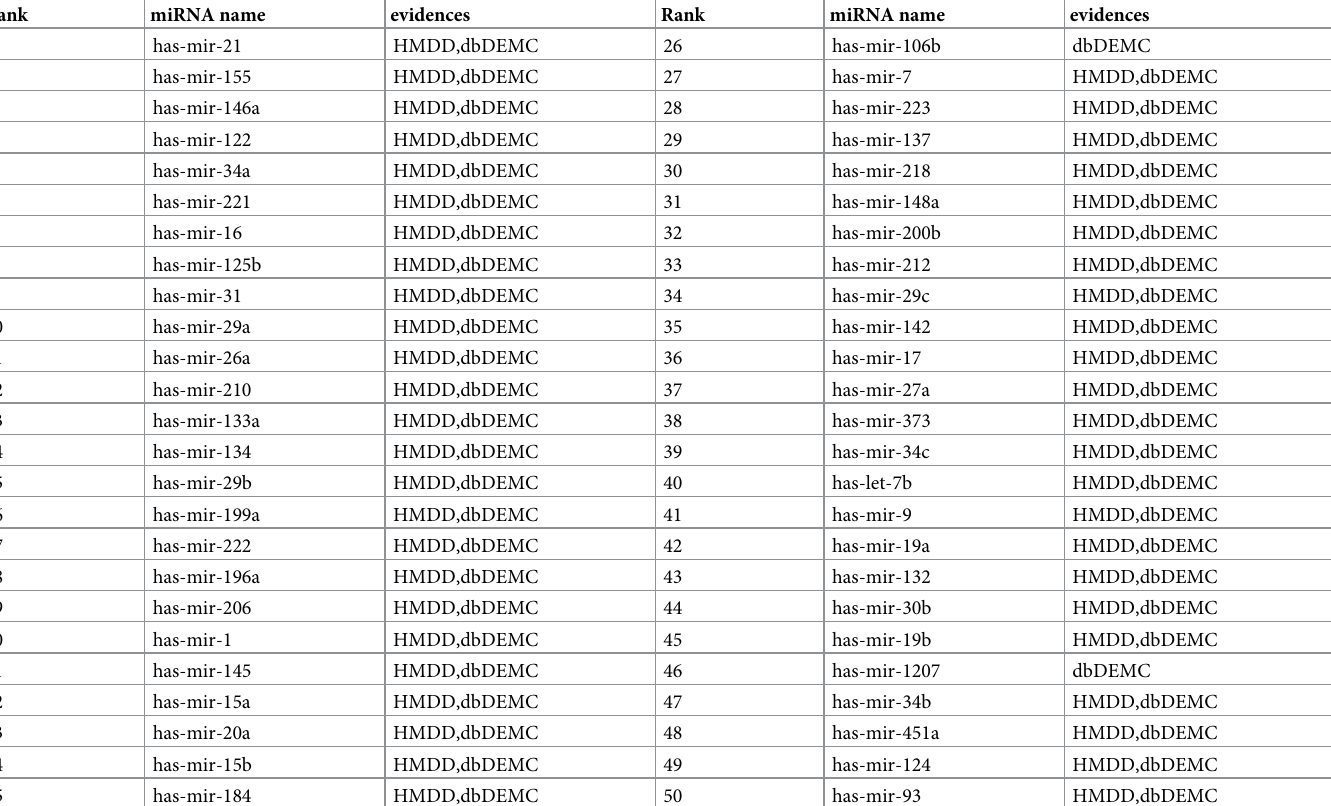
Table 3. The top 50 lung neoplasms–related miRNAs candidates predicted by NPRWR with removed all known lung neoplasms–miRNAs associations and the con- firmation of these